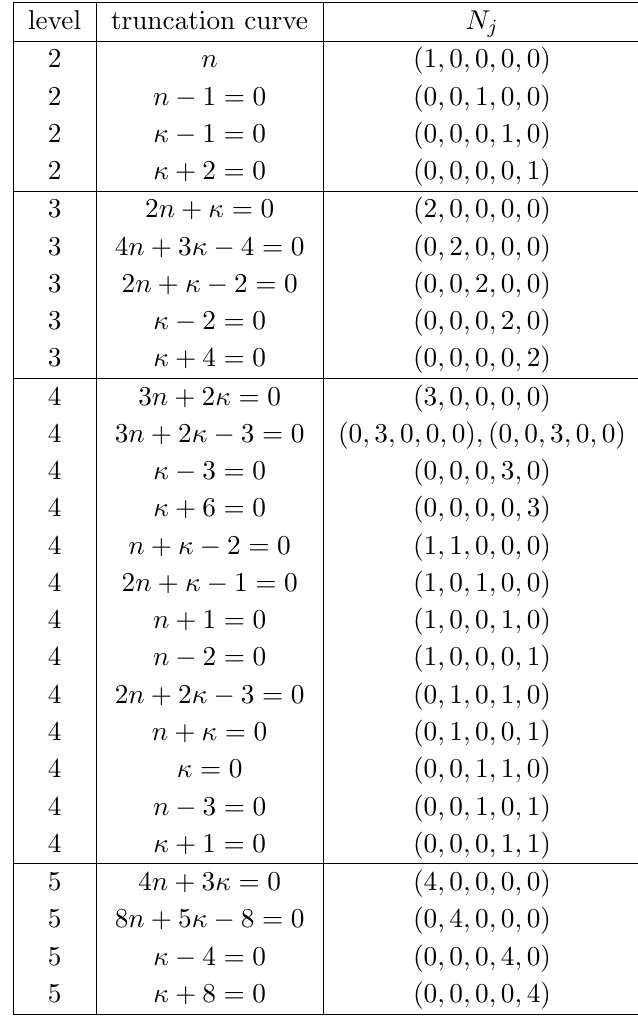
Table 4 . Truncation curves of Lagrangian Grassmannian family of algebras up to level